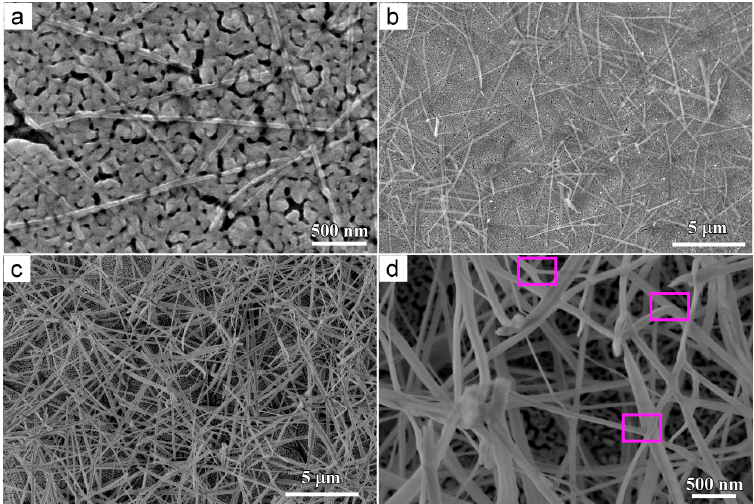
Figure 3. Microimages of Cu 2 O nanobelts on nanoporous Cu after free immersion in ethanol for 24 h ( a ), 48 h ( b ), 72 h ( c ), and high magnified morphology of c ( d ).